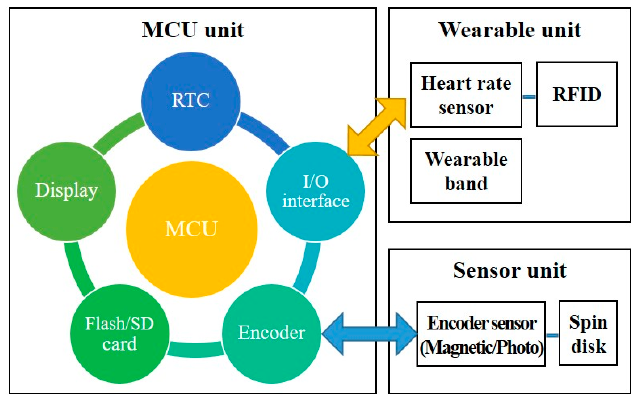
Figure 2. The proposed IoT pack for exercise tracking and its network for other applications. (RTC: real-time clock, MCU: microcontroller unit, I/O interface: input/output interface).